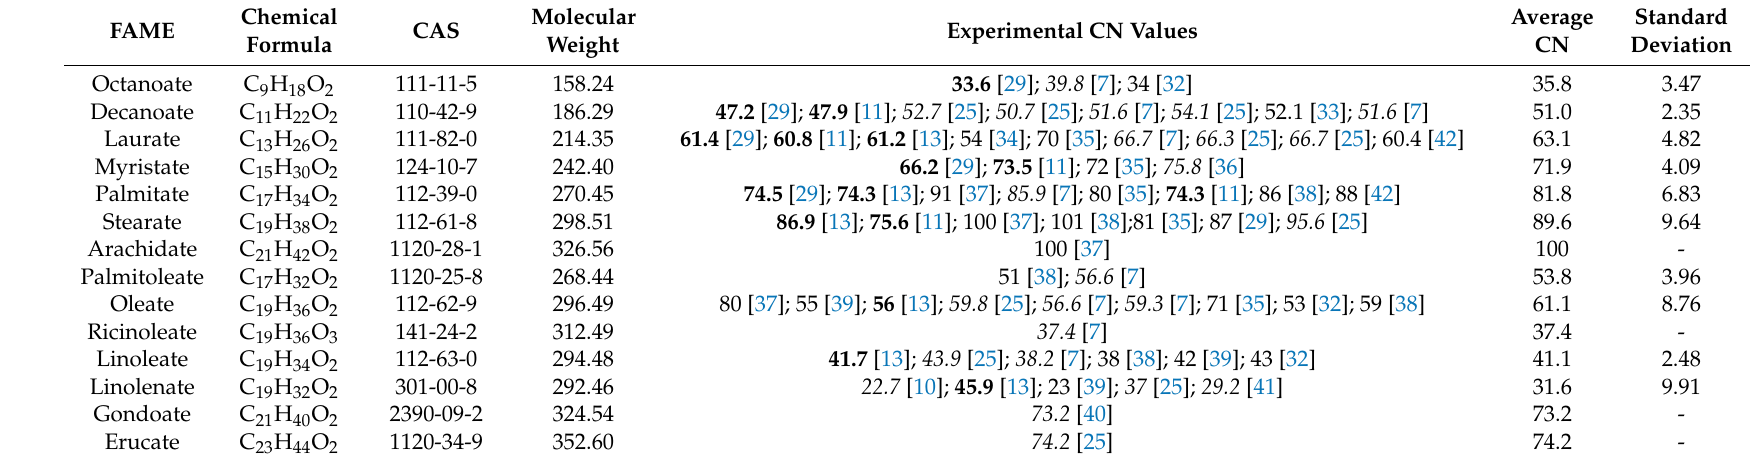
Table 2. Experimental CN values for pure FAMEs (CNs in bold correspond to the CFR method and in italics to the IQT